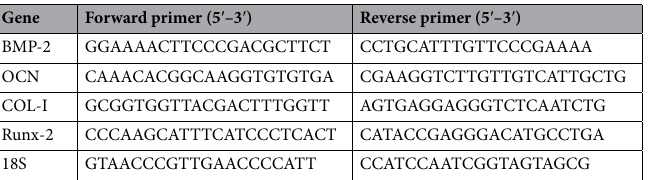
Table 1. Primer sequences of selected genes to osteogenic differentiation of BMSCs.